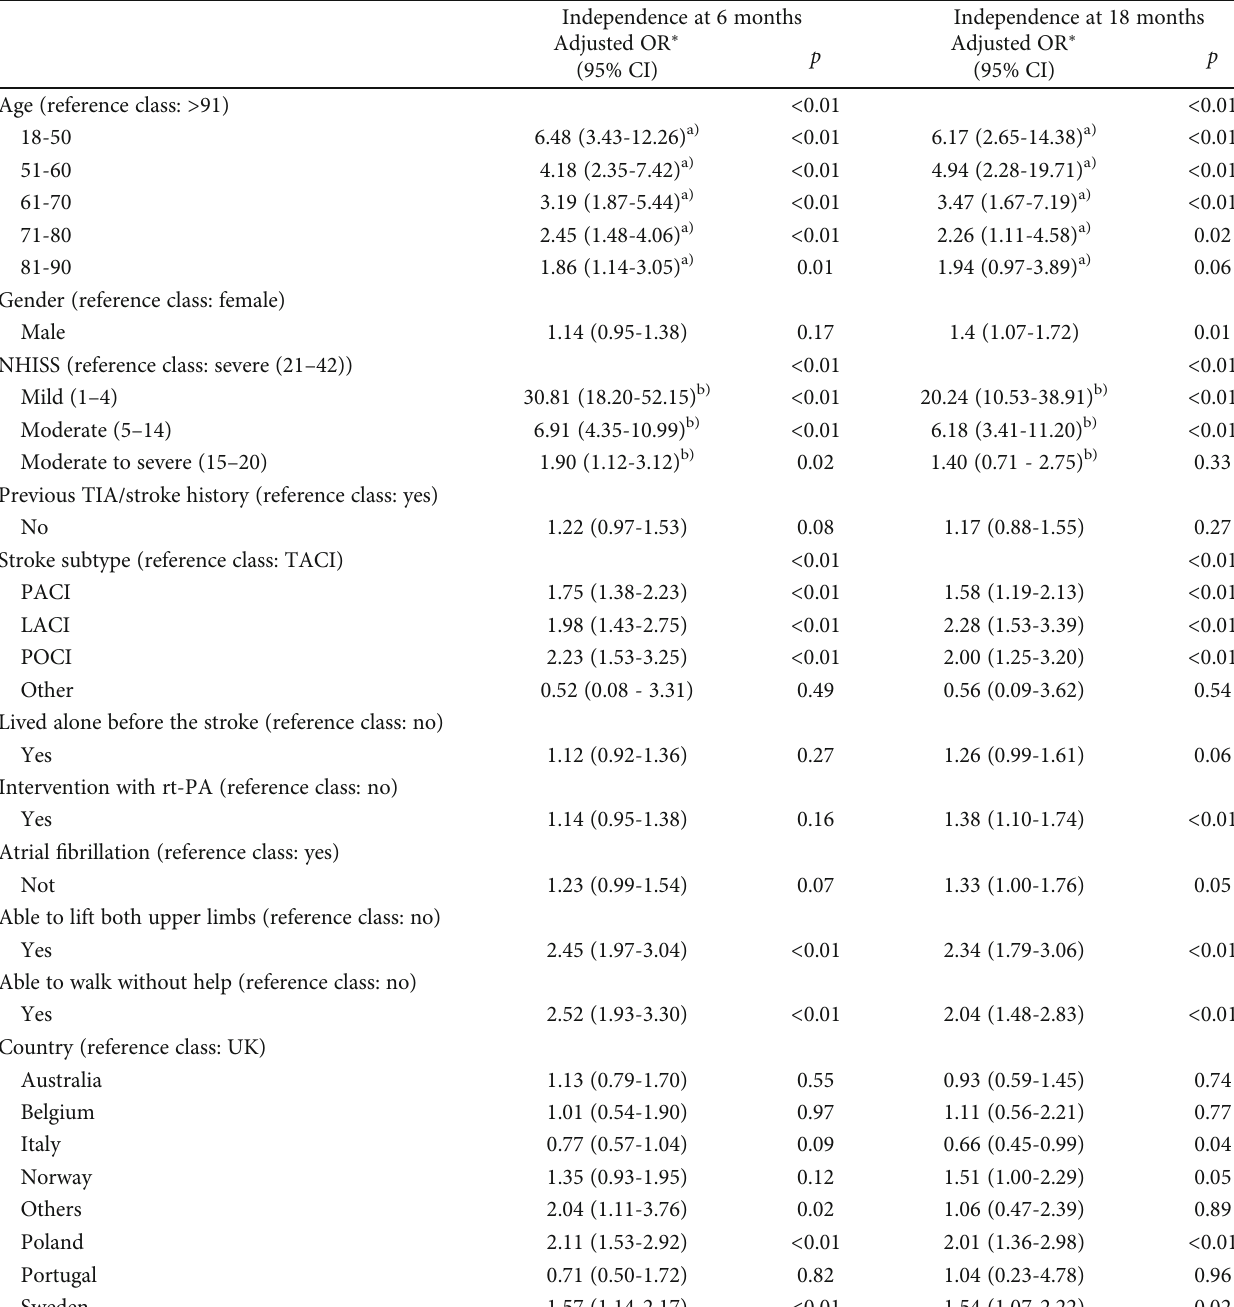
Table 4: Predictors for independence at 6 and 18 months poststroke adjusted for age and severity, with OR and 95%